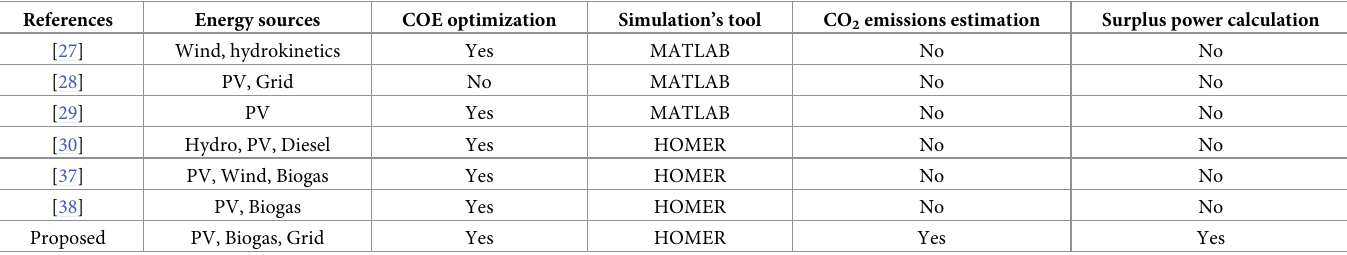
Table 2. Related